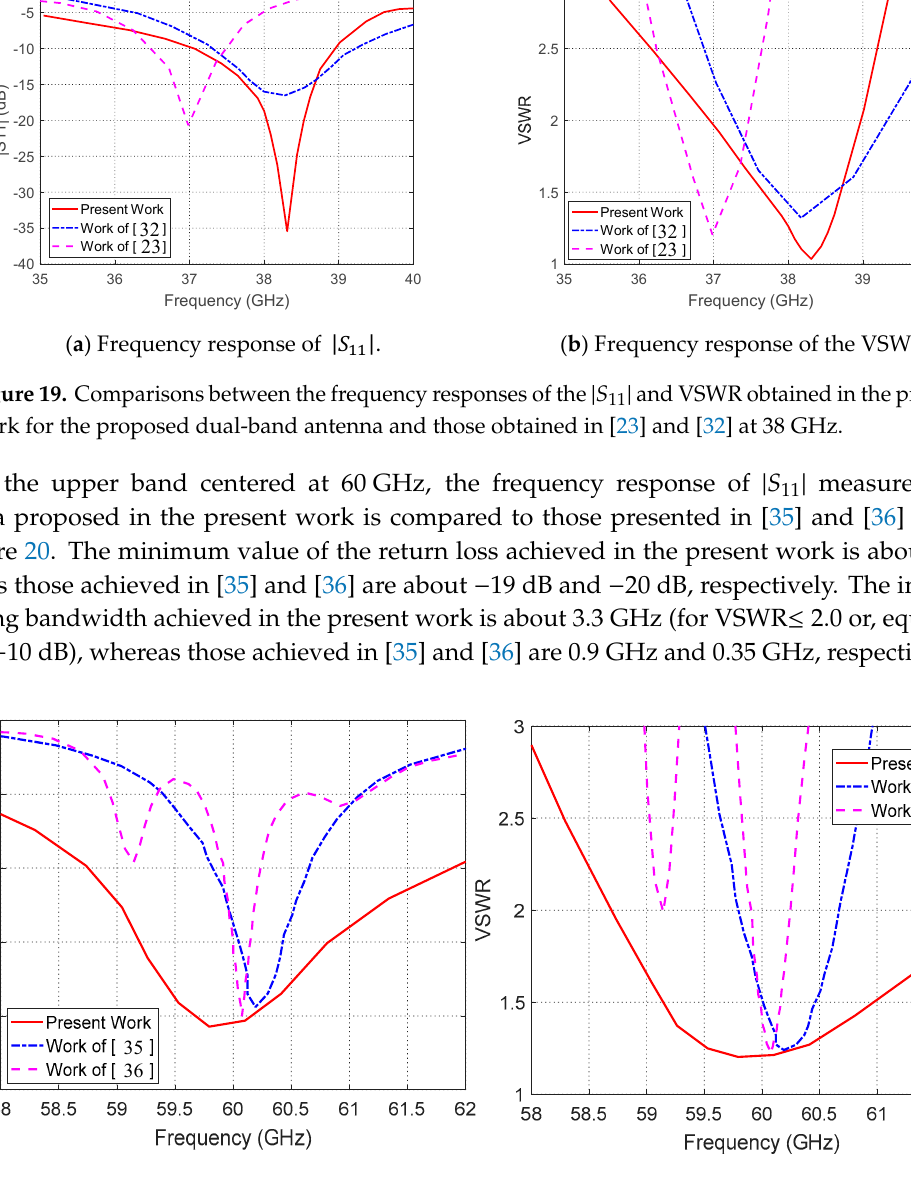
( a ) Frequency response of |(cid:1845) (cid:2869)(cid:2869) | . ( b ) Frequency response of the VSWR. Figure 20. Comparisons between the frequency response of the | S 11 | obtained in the present work for the proposed dual-band antenna and those obtained in [35] and [36] at 60 GHz .